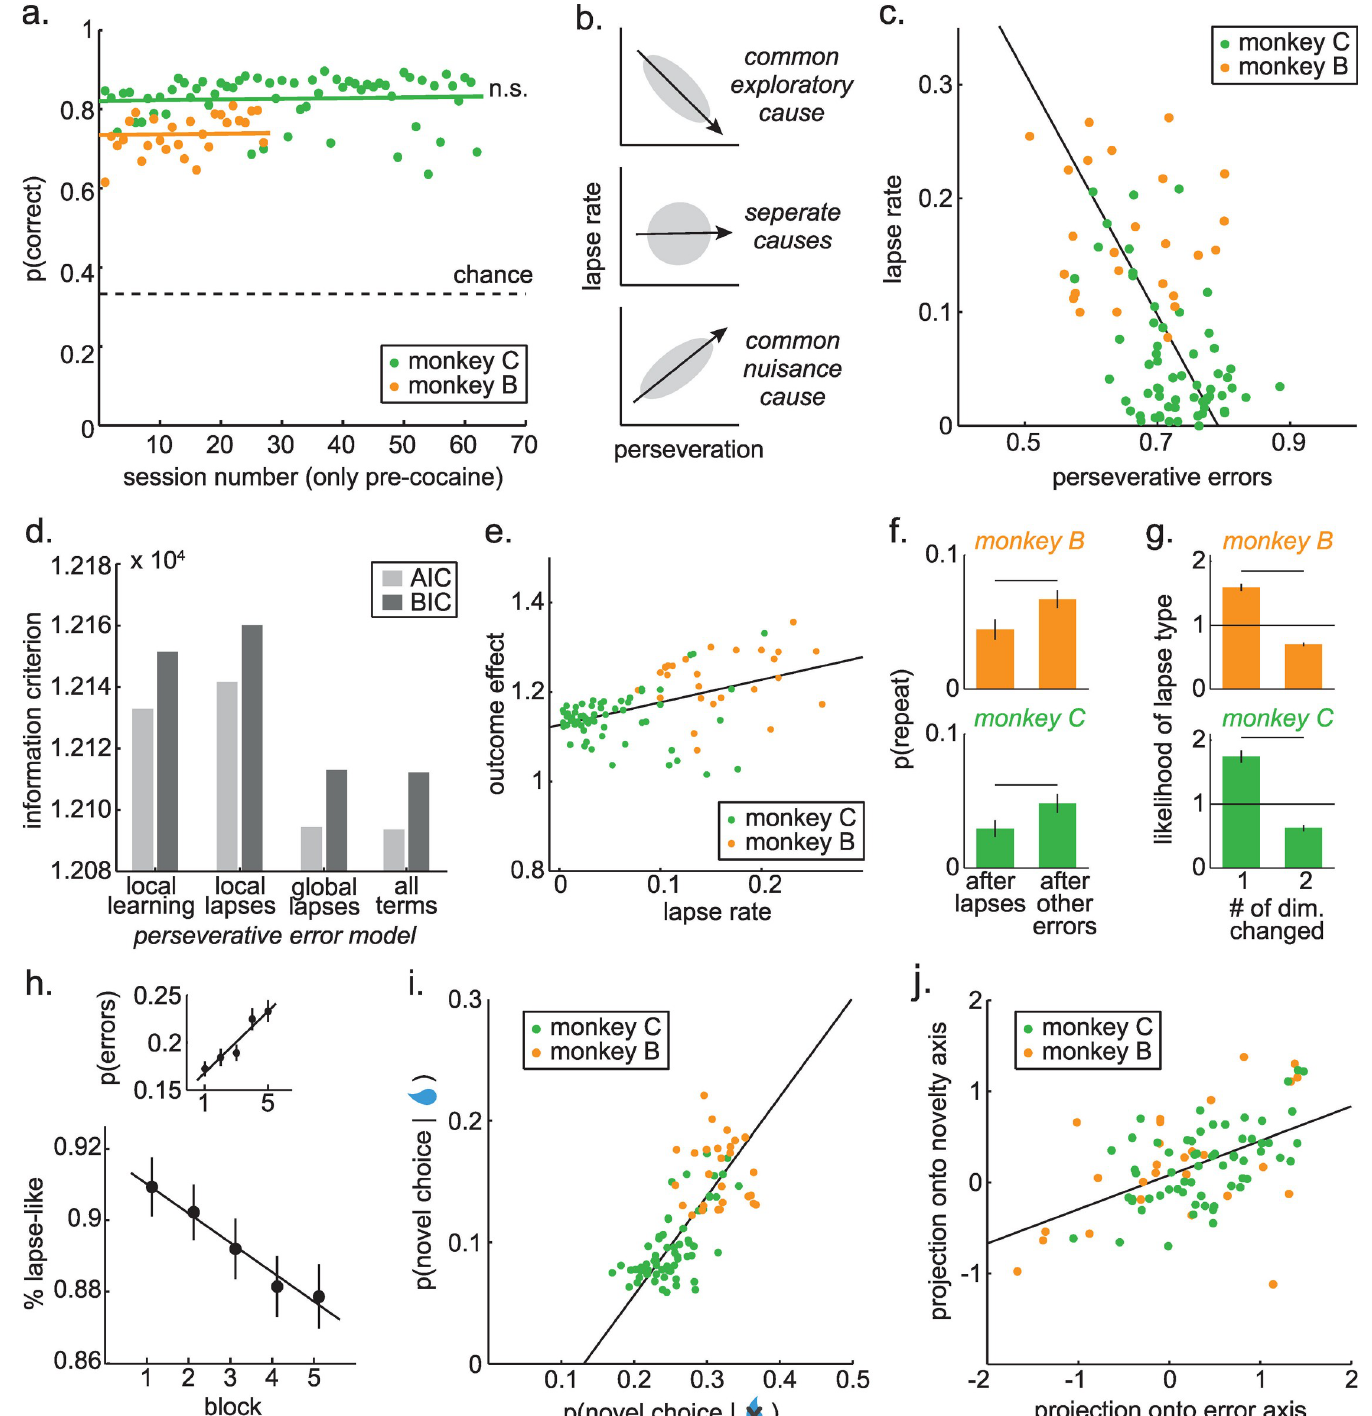
Fig 2. Behavior in baseline sessions. A) Percent correct as a function of session-number in the baseline sessions, plotted separately for monkey C (green dots) and monkey B (orange). Lines = GLM fits (Results). n.s. = not significant. B) Possible relationships between lapse rates and perseverative errors under different hypotheses. Top) A negative correlation if some spontaneous lapses are caused by the same exploratory process that facilitates learning and reduces perseveration at change points. Middle) No correlation if lapses and perseveration are caused by different underlying error processes. Bottom) A positive correlation if lapses and perseveration are